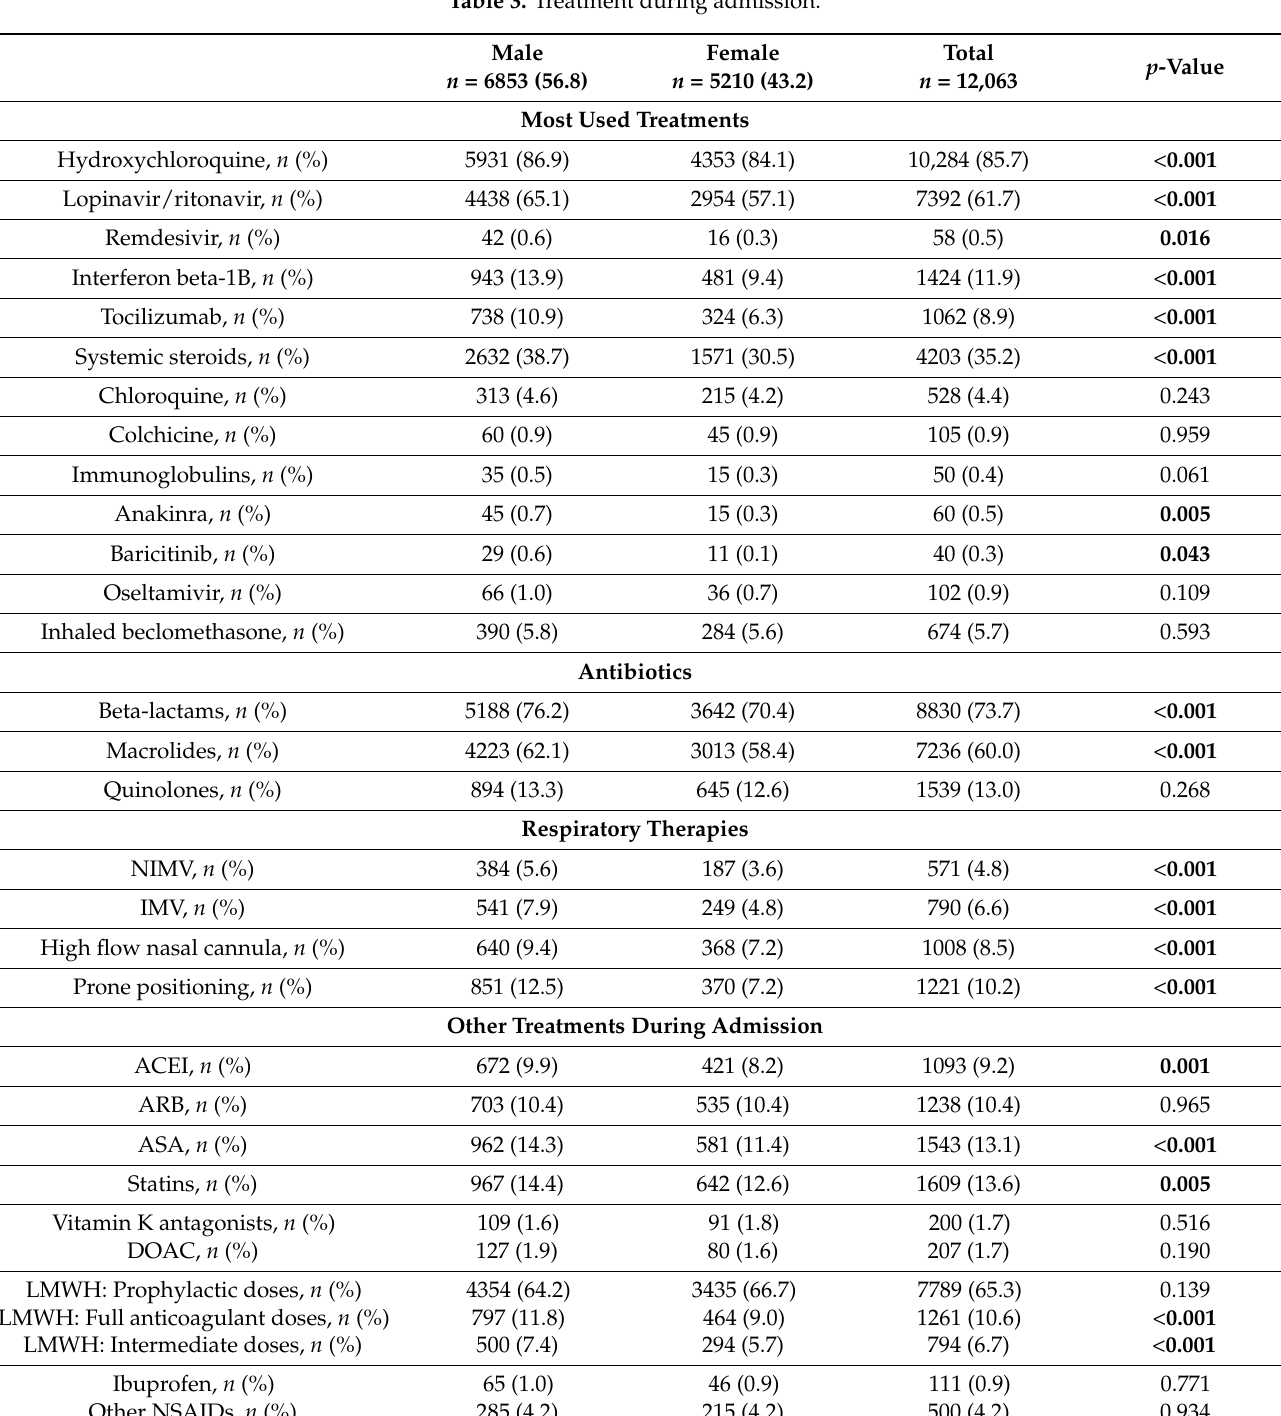
Table 3. Treatment during